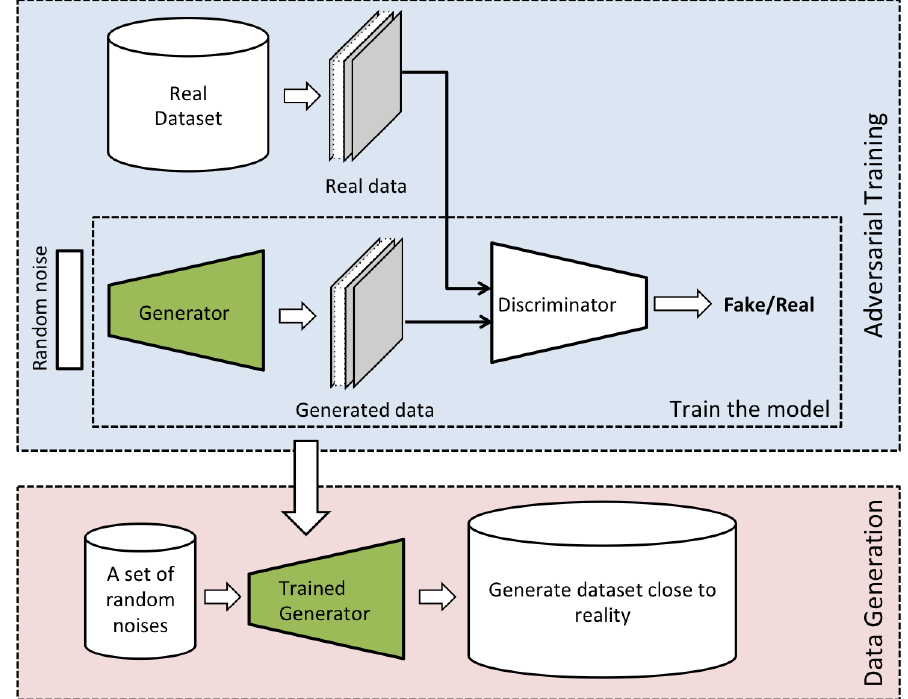
Figure 11. A general schema of generative adversarial network (GAN) depicting how a generative model gets trained and how the trained generator is used to create the